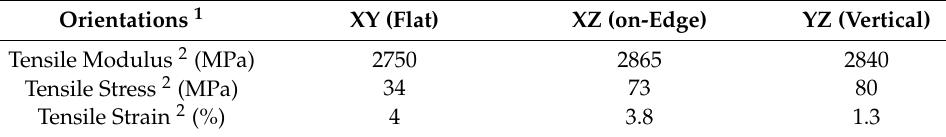
Table 1. ULTEM TM AM1010F biomaterial used in this study [15].